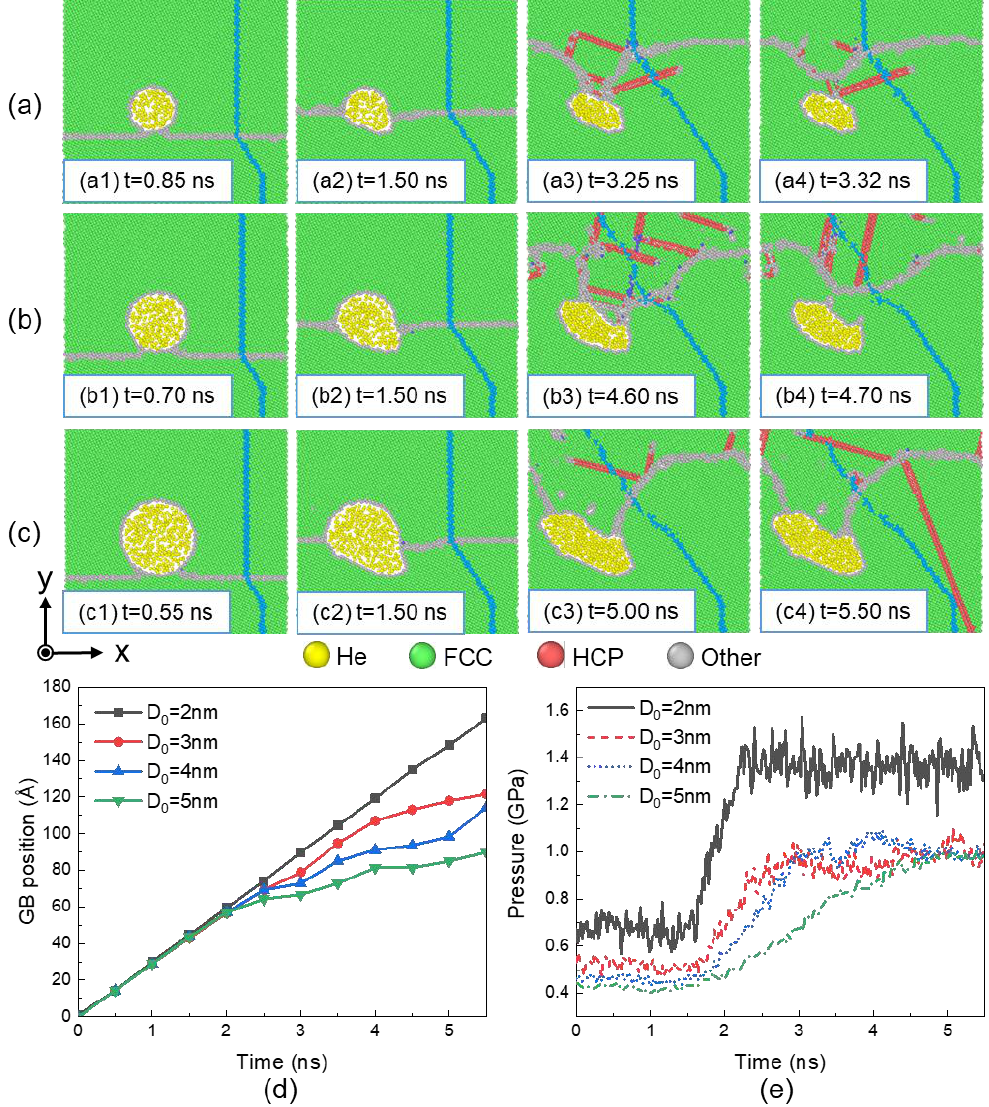
Figure 8. Snapshots of the interaction process between GB and He bubble for samples with different D 0 at R He/V =0.5 and T 0 = 300 K, and the corresponding evolution of GB position and He bubble pressure. ( a – c ) Cross-sectional view of the dynamic interaction process: ( a ) D 0 = 3 nm; ( b ) D 0 = 4 nm; ( c ) D 0 = 5 nm; ( d ) GB position; ( e ) He-bubble